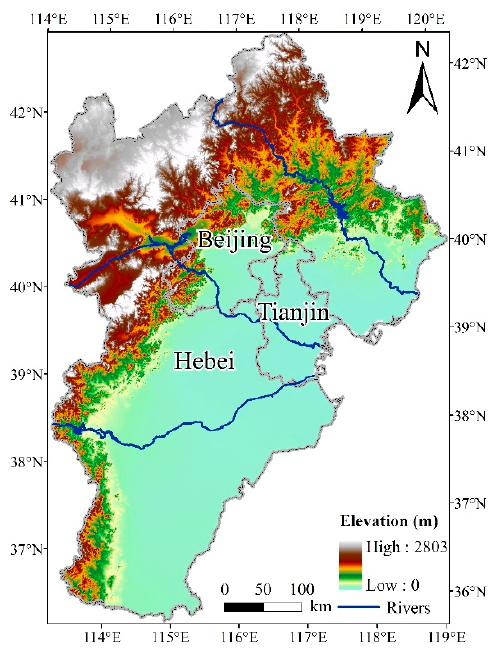
Figure 1. Location of the Beijing-Tianjin-Hebei region.